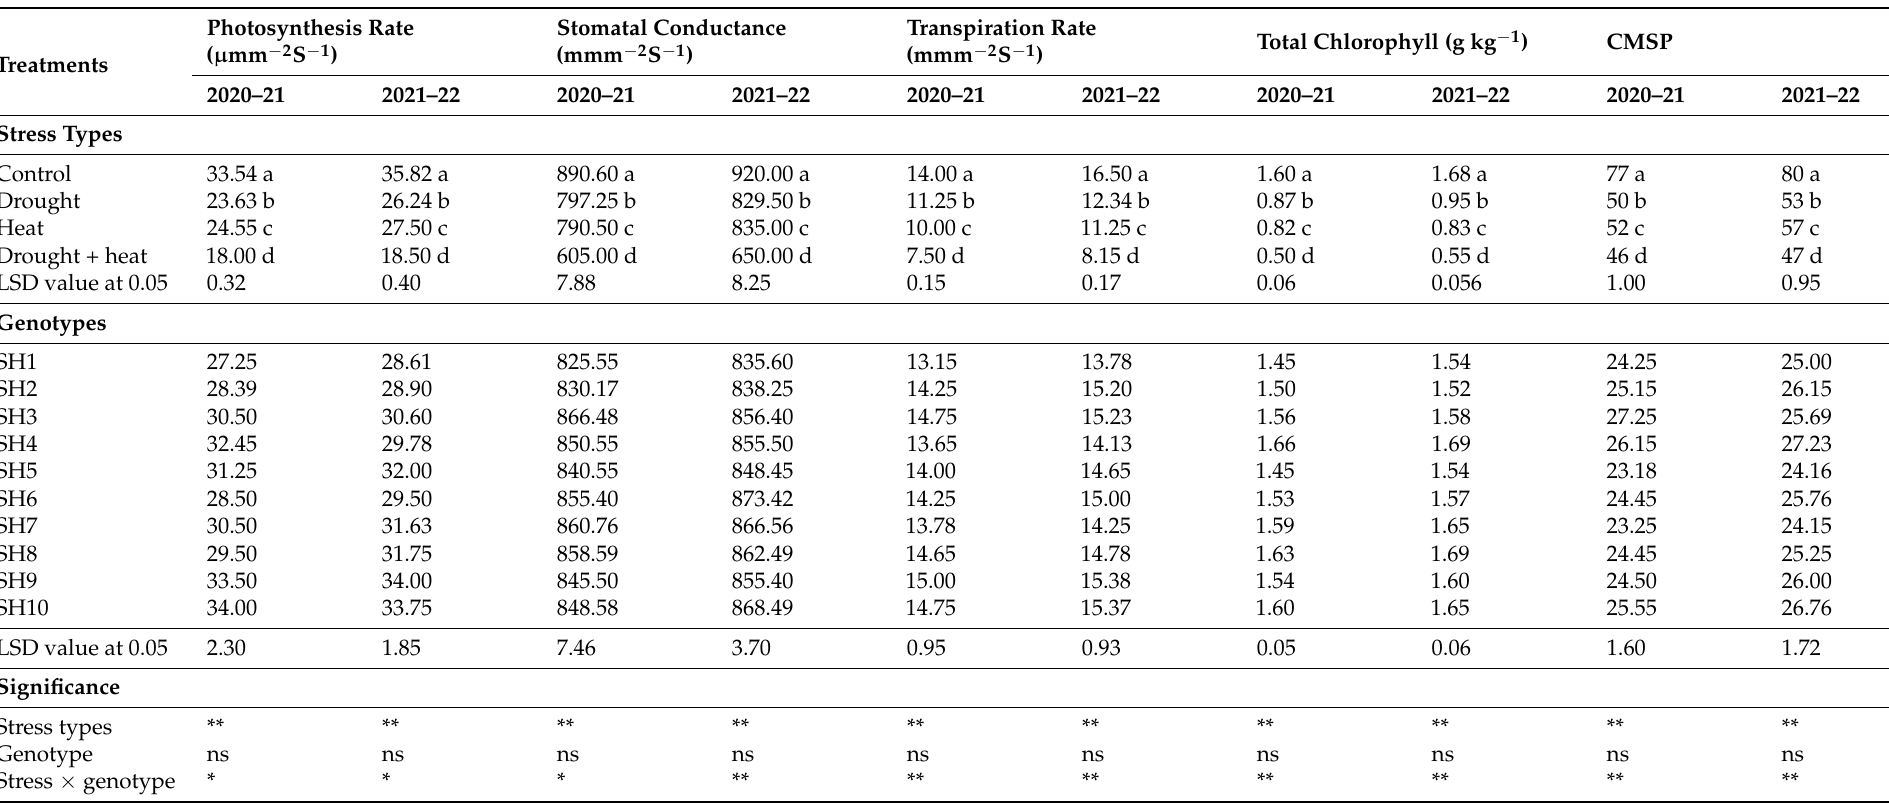
Table 3. Variation in physiological parameters of different synthetic hexaploid wheat genotypes due to individual and combined application of drought and